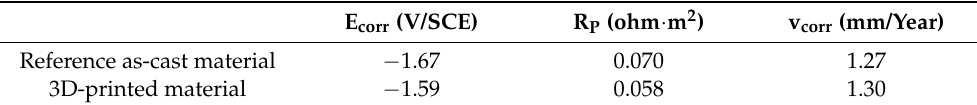
Figure 10. Potentiodynamic curves of the investigated materials (SBF solution). Table 4. Results of potentiodynamic test of 3D-printed and reference material (SBF